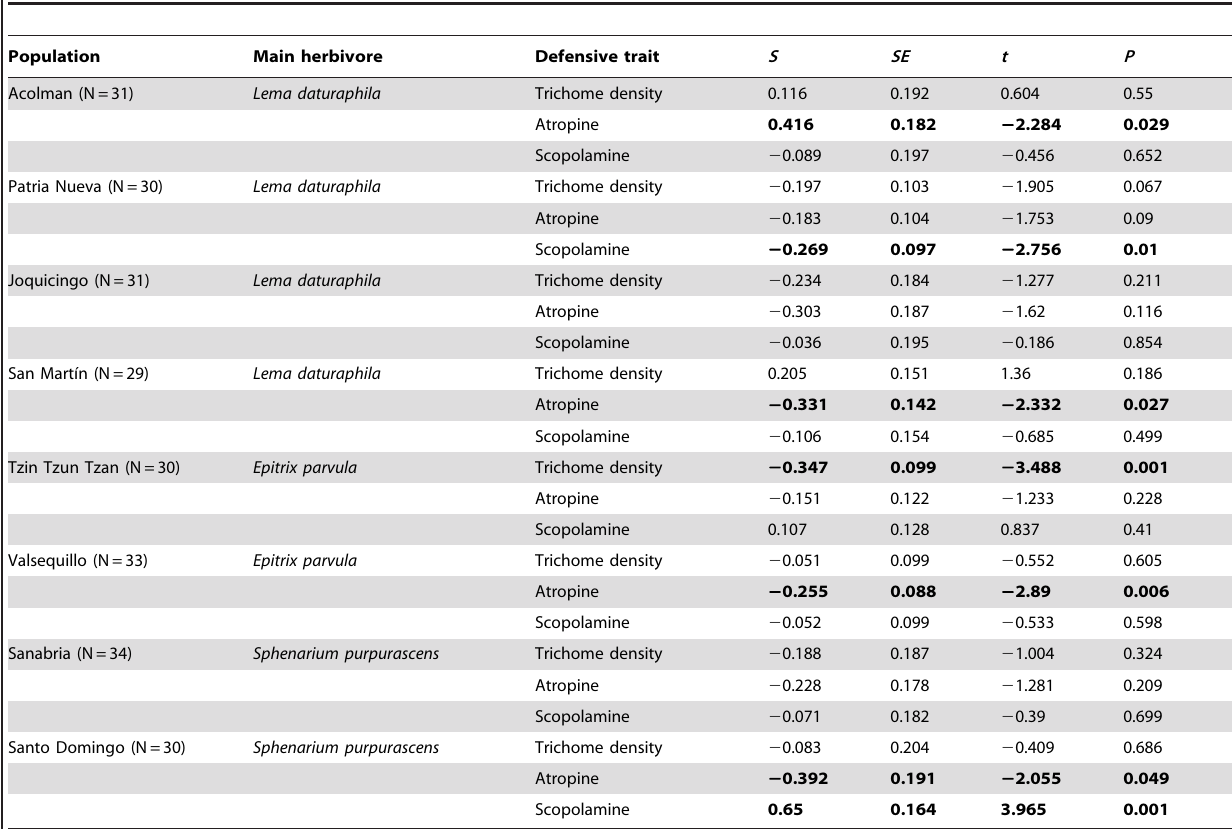
Table 1. Selection differentials ( S ) of trichome density, atropine, and scopolamine concentration in eight populations of Datura stramonium